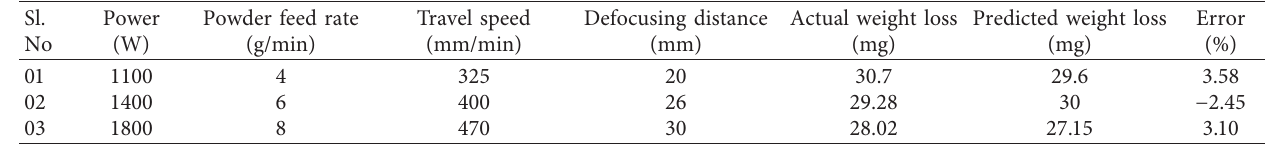
Table 7: Verification results for wear test weight